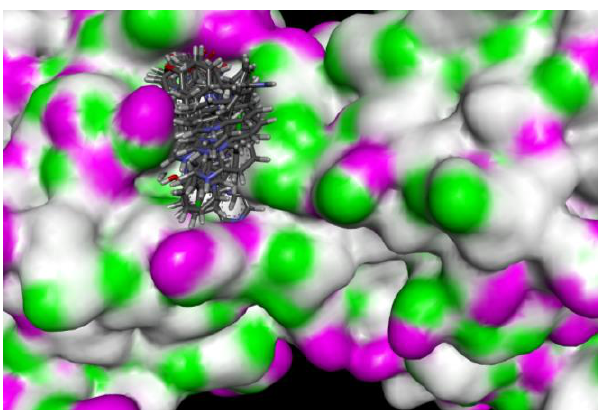
Figure 2. Detection of binding sites using Sitemap tool.